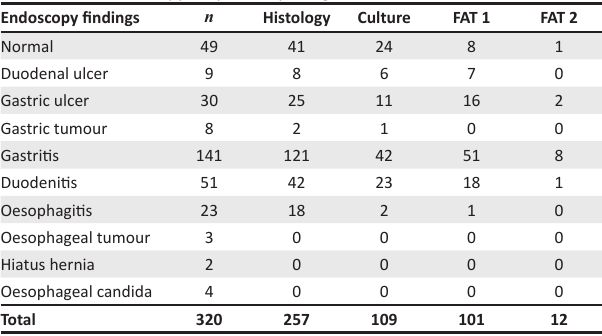
TABLE 7: Helicobacter pylori positivity using the three deferent methods. Endoscopy